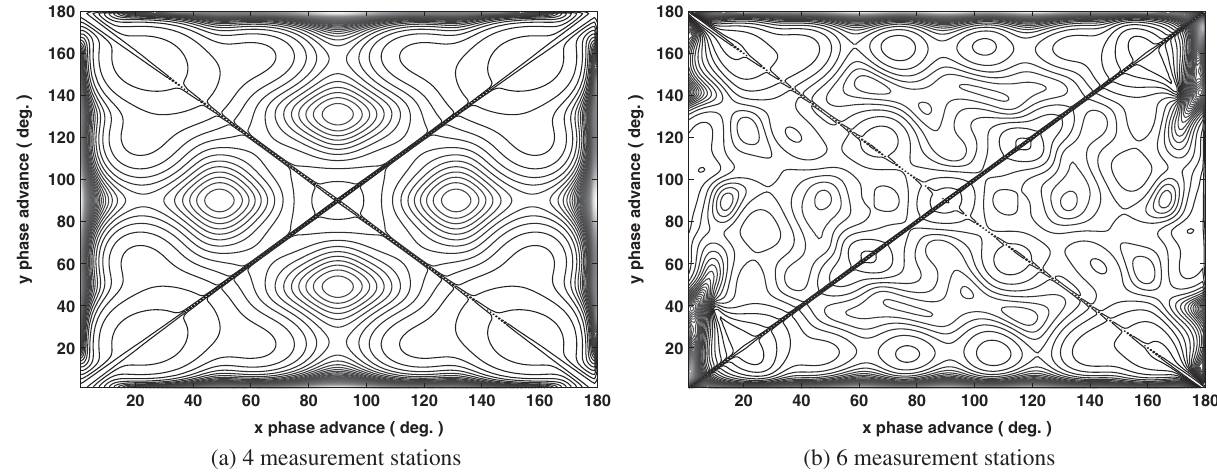
FIG. 8. Contour plots of 2 = (cid:6) 1 (cid:4) (cid:11)